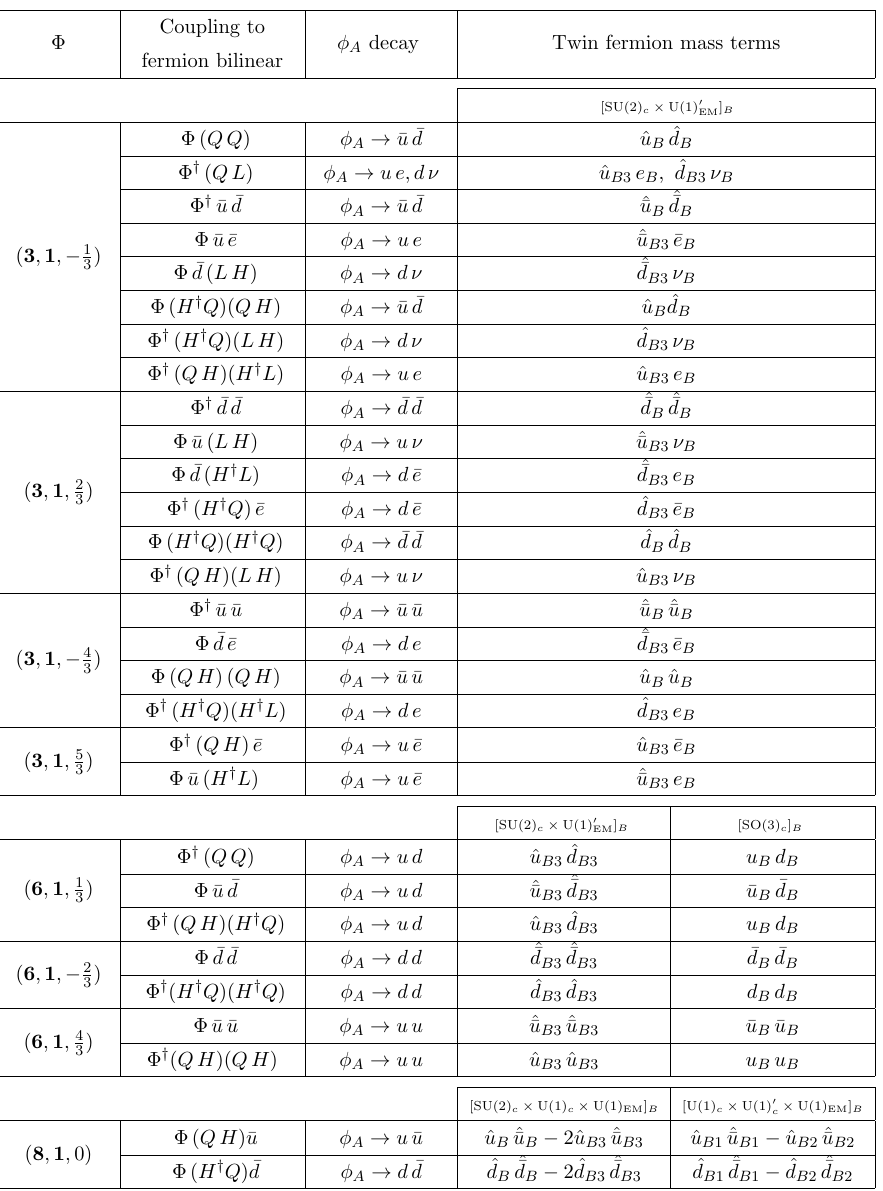
Table 2 . SU(2) L singlet scalar representations and allowed couplings to fermion bilinears. Each coupling leads to the indicated decays of (cid:30) A to SM fermions, as well as new twin fermion mass terms for the indicated unbroken twin gauge